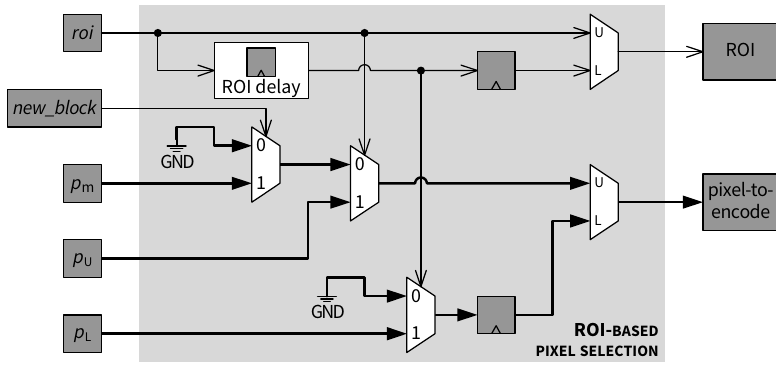
Figure 22. ROI-based pixel selection module.